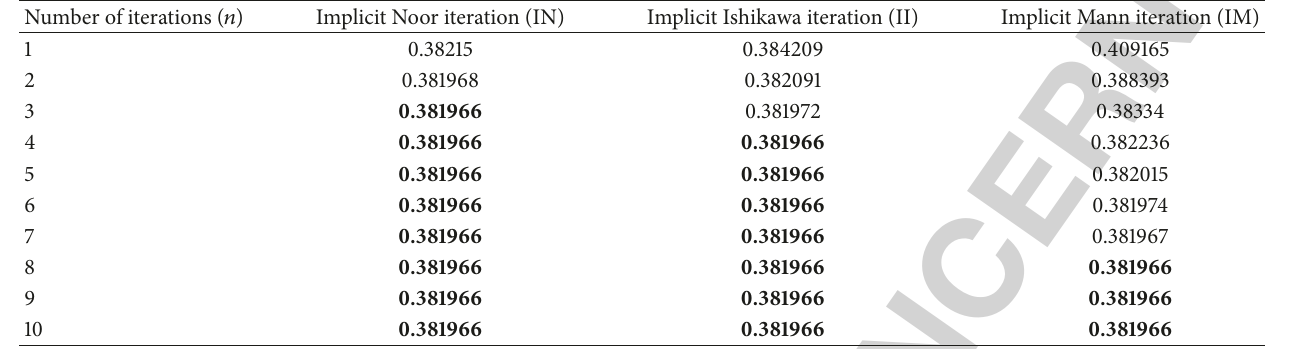
Table 2: Convergence of implicit iterations to the fixed point of decreasing function.